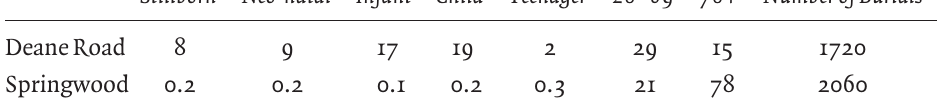
Table Interments by age category (percentage) at Deane Road and Springwood cemeteries Stillborn Neo-natal Infant Child Teenager 20–69 70+ Number of